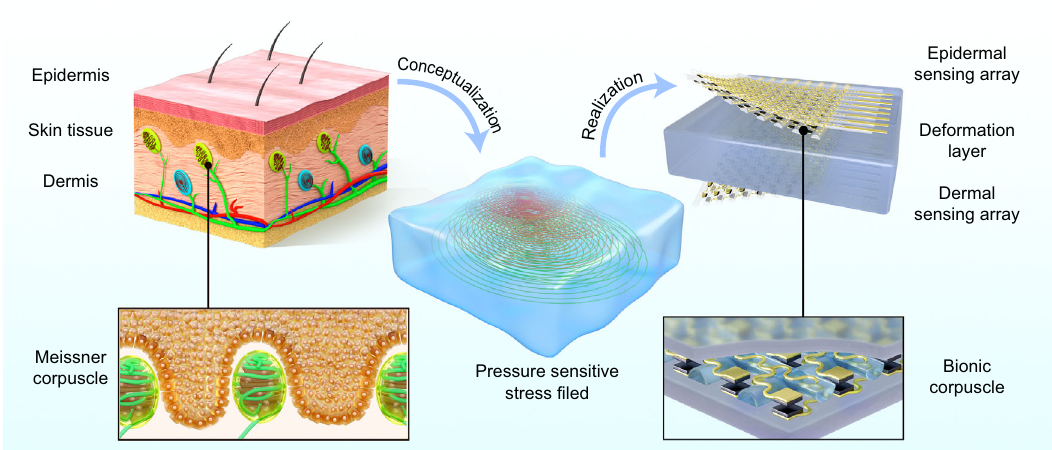
Fig. 1 Concept of stress fi eld sensing and bio-mimicking of Meissner corpuscle structures. Left side of the fi gure shows the construction of human skin. A large number of Meissner corpuscles, Merkel discs, and tactile nerve endings are distributed in the epidermis of the skin, while Ruf fi ni corpuscles and Pacinian corpuscles are distributed in the dermis. When external force is present, the skin undergoes corresponding deformations that change the surrounding environment of the tactile corpuscles and nerve endings. The nerve signals characterize the stress fi eld of the soft skin tissue, which re fl ects the external force. Based on this stress fi eld sensing concept, we propose the BMRs idea as shown in right side of the fi gure. An extremely soft Eco fl ex Gel is used as a deformation layer in the middle to act as the carrier of the stress fi eld. The ‘ epidermal ’ sensing array and ‘ dermal ’ sensing array are used to sample the pressure distribution on the top and bottom surface of the deformation layer, respectively. The microstructure of the Meissner corpuscles is shown in the lower left block diagram. Tissues wrapping around the Meissner corpuscles help them work stably at large deformation. Inspired from this special structure, the sensing units are isolated from each other with silicone structure as shown in lower right block diagram. They are suspended and protected in separate